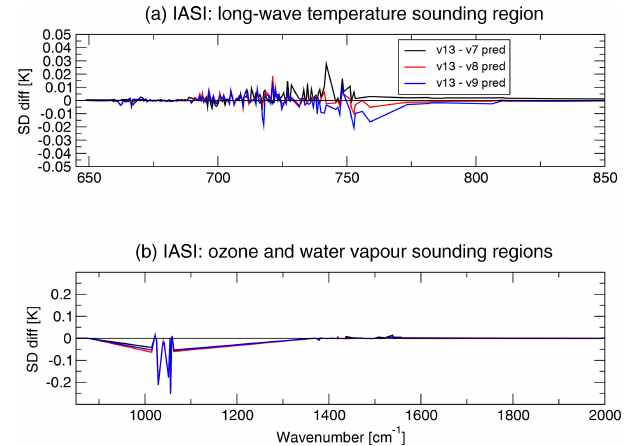
Figure 17. For selected IASI channels in band 1 (a) and band 2 (b) , the difference of the standard deviations of the brightness tempera- ture fit between v13 predictors and the v7 predictors with variable O 3 (black line), v13 predictors and the v8 predictors with variable O 3 and CO 2 (red line), and v13 predictors with all seven variable gases and the v9 predictors with six variable gases (blue